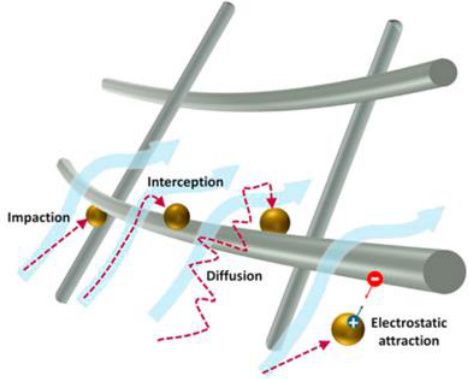
Figure 5. Four major types of particle filtration mechanisms: impaction, interception, diffusion, and electrostatic attraction [196].